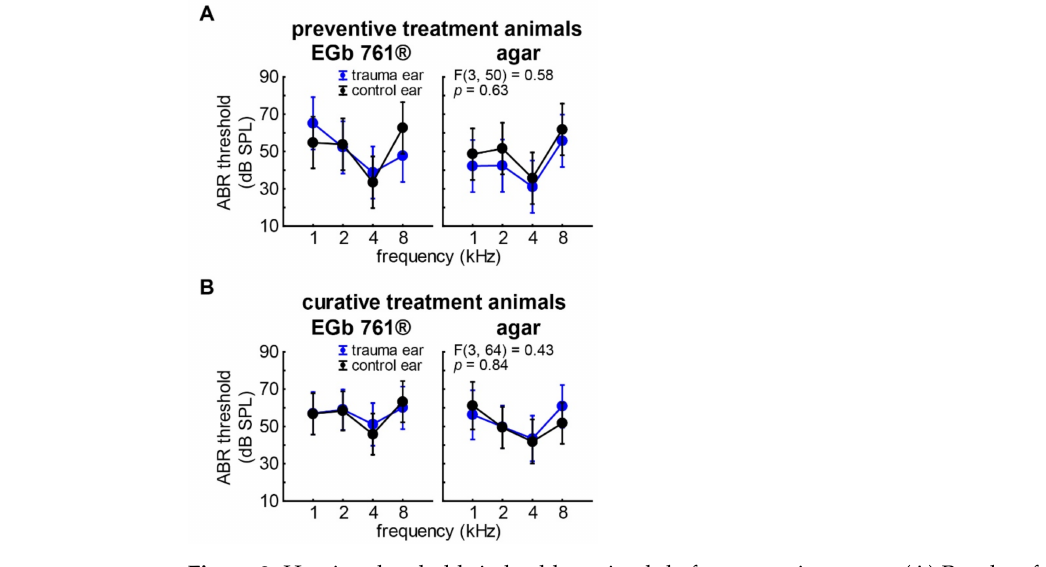
Figure 3. Hearing thresholds in healthy animals before acoustic trauma. ( A ) Results of the repeated- measurement ANOVA (factor ear : trauma ear (i.e., ear that was later traumatized) = blue, control ear = black) interaction plot (factors frequency : 1, 2, 4, 8 kHz; application group : EGb 761, agar) of hearing thresholds (dB SPL) of the 16 healthy animals in the preventive treatment group. Given are the mean values as filled circles and the 95% confidence intervals as whiskers, as well as the F-statistics of the interaction of all three factors on the ABR thresholds as an overview. ( B ) Results of the repeated- measurement ANOVA of hearing thresholds of the 21 healthy animals in the curative treatment group. For details of ANOVAs, see Table 1.